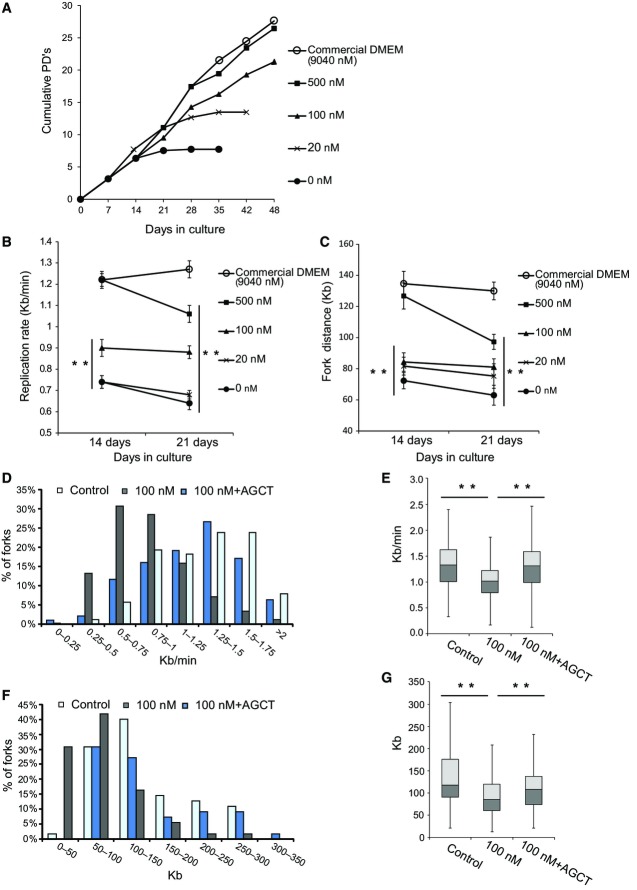
Growth rate and replication dynamics in BJ cells grown under various folate concentrations with and without nucleoside supplementation
A Population doublings (PDs) determined in BJ cells cultured at the indicated folate concentrations for 48 days.

B, C The average replication rate ± SEM (B) and the average fork distance ± SEM (C) in the indicated folate concentrations at 14 and 21 days. At least 115 DNA fibers were analyzed at each concentration and at each time point to determine the average replication rate. At least 71 replication forks were analyzed at each concentration and at each time point to determine the average fork distance.

D–G BJ cells were grown for 14 days in 100 nM folate with and without nucleoside supplementation. (D) Fork rate (Kb/min) distribution. Light blue bars: BJ cells (n = 115); gray bars: BJ cells that were cultured for 14 days in 100 nM folate (n = 117); blue bars: BJ cells cultured for 14 days in 100 nM folate and supplemented with A, G, C, and T nucleosides for the last 48 h of the experiment (n = 117). (E) Box plot summarizing the fork rate distribution (Kb/min) of three independent experiments. Control (n = 352); 100 nM folate (n = 364); 100 nM folate + AGCT (n = 355). Main box represents the values from the lower to upper quartile (25th to 75th percentile). The middle line represents the median. (F) Fork distance (Kb) distribution. The color code is as in (D). Control (n = 69); 100 nM folate (n = 74); 100 nM folate + AGCT (n = 72). (G) Box plot summarizing the fork distance distribution (Kb) of three independent experiments. Control (n = 201); 100 nM folate (n = 220); 100 nM folate + AGCT (n = 228). Main box represents the values from the lower to upper quartile (25th to 75th percentile). The middle line represents the median. **P < 0.001.